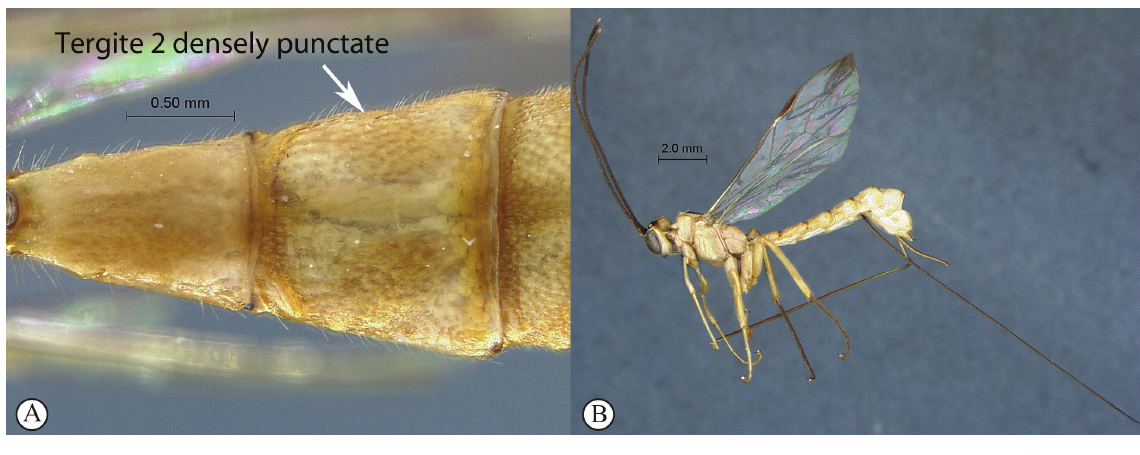
9. Tergite 2 densely punctate over its entire surface and tergite 1 more than 1.5x longer than apically